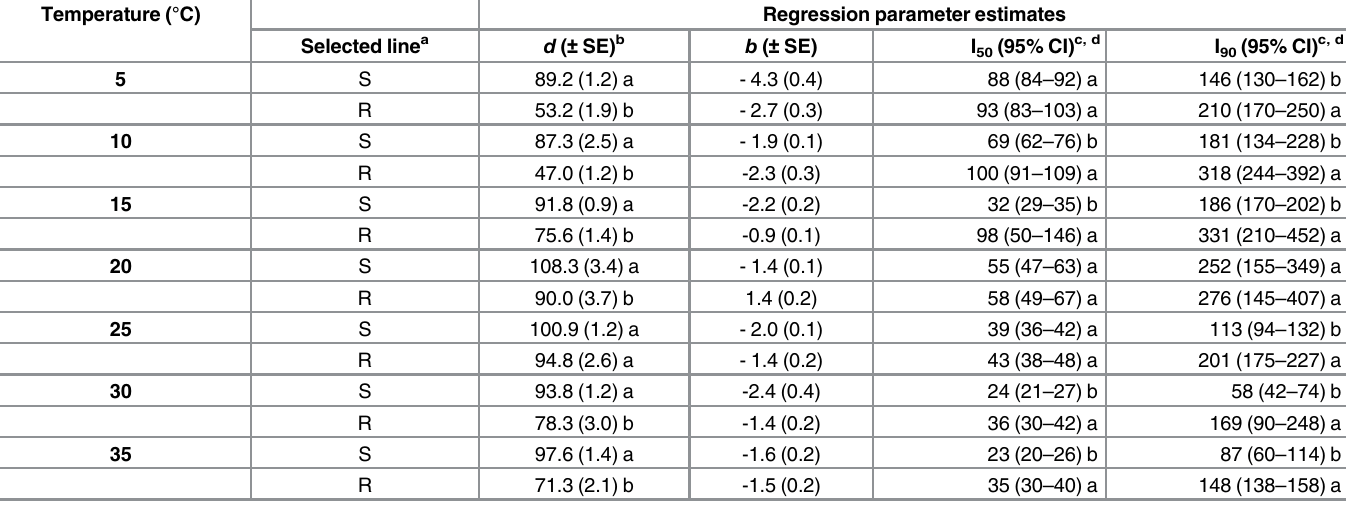
Table 1. Regression parameters estimated from the three-parameter log-logistic model (Eq 1: d = upper limit, b = slope) for percent cumulative ger- mination of dicamba-fluroxypyr – susceptible (S) and – resistant (R) K . scoparia at various constant temperatures averaged over experimental runs. Temperature (°C) Regression parameter estimates Selected line